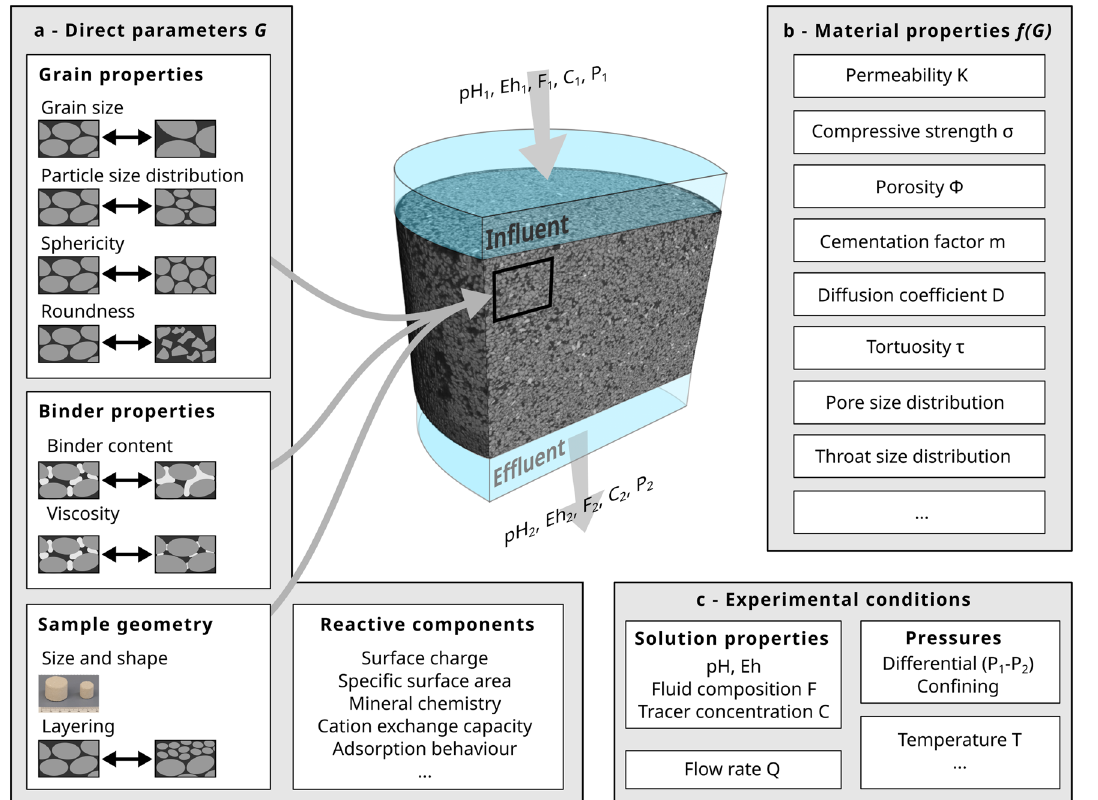
adjusted when preparing the sample. b Material properties that are a function of direct parameters. c Examples of experimental con- ditions that can be monitored or adjusted in flow-through experi-